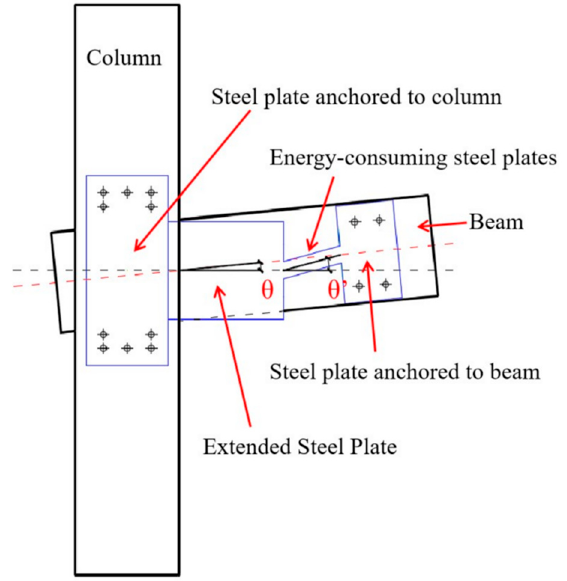
Figure 1. Working principles of the innovative metal dampers.